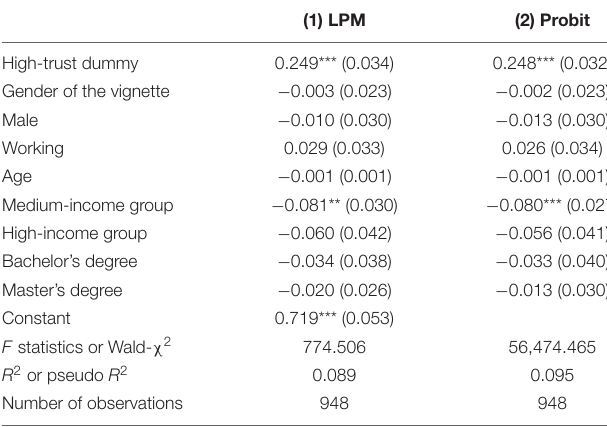
FIGURE 2 | Trust manipulation in the experiment. Trust in the health system in the experiment.